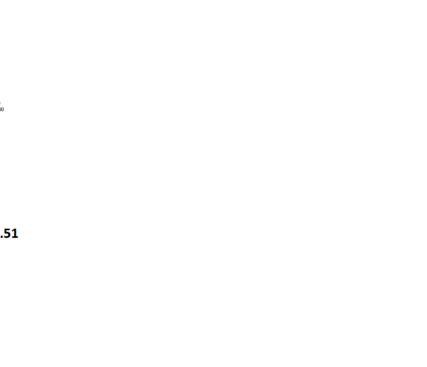
Figure 5. Emissions of CO of engine in ESC 13 mode test fed with D ( a ), with DB fuel ( b ), and with DF fuel ( c